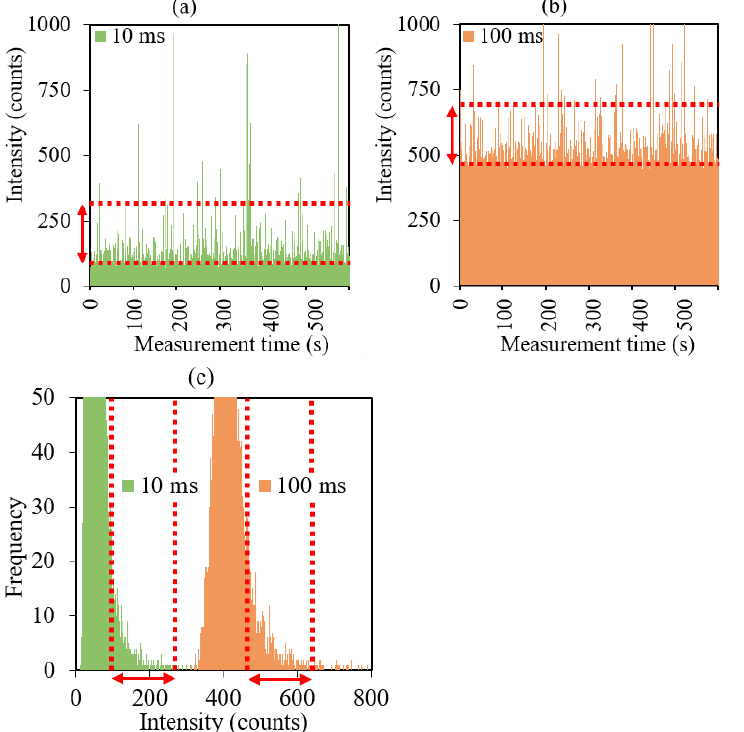
Figure 3. Time-resolved spectra at dwell times of ( a ) 10 and ( b ) 100 ms; ( c ) signal distributions of sample 3. sample